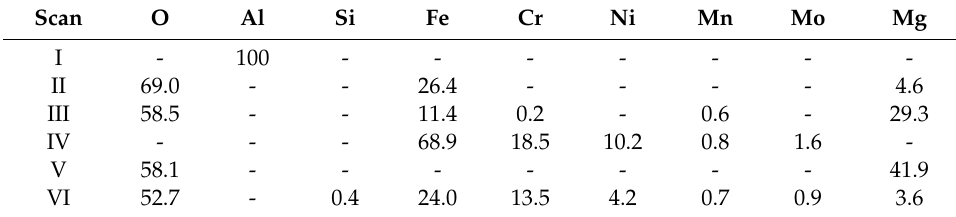
Figure 9. SEM micrographs of W_850 sample after the test with AlSi7Mg0.3 at 850 ◦ C: ( a ) image magnified to 30 × ; ( b ) image magnified to 300 × . Table 9. Results of EDS scans indicated by arrows in Figure 9 (in at